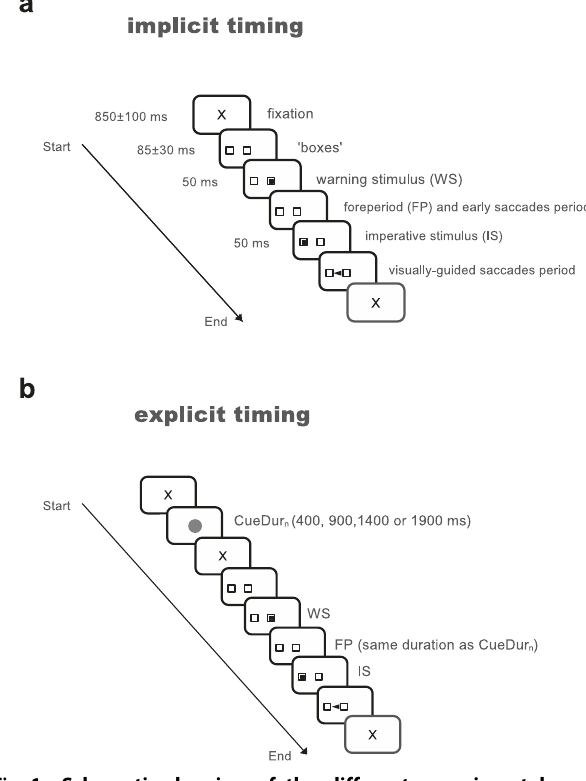
Fig. 1 Schematic drawing of the different experimental condi- tions. Subjects were facing a computer screen on which stimuli were displayed. a Implicit timing condition: the trial started with the appearance of a fi xation cross for a randomized duration followed by the appearance of two empty ‘ boxes ’ , one at the center of the screen and a second one at a 9-deg eccentric position. After the appearance of the two boxes, a target was brie fl y presented in the central one for 50 ms. Disappearance of the central target marked the beginning of the foreperiod (FP) that could last either 400, 900, 1400, or 1900 ms. At the end of this delay period, a target appeared for 50 ms in the eccentric box. The instruction given to subjects was to make a visually-guided eye saccade to the eccentric target as soon as possible. However, ‘ early ’ saccades occurred frequently during the FP. b Explicit timing condition: the trial started with a fi xation cross (same duration as in implicit condition), followed by the cue period when a red disk was presented on the screen for one of the four durations selected randomly. A short fi xation period followed and the two empty boxes appeared on the screen. The end of the trial was similar as in the implicit case. Cue duration allowed subjects to predict upcoming FP